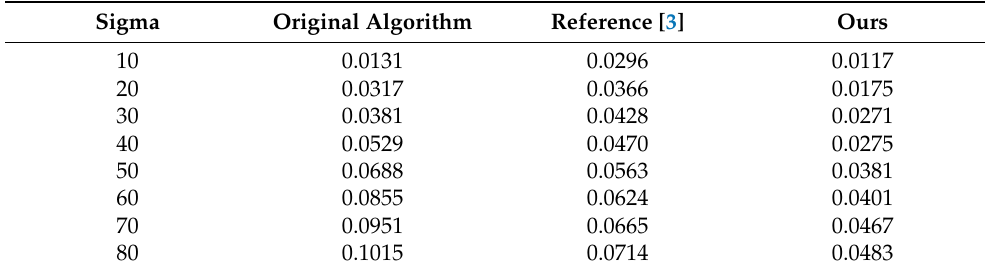
Figure 1. Detection results of the Cameraman image by the tested algorithms at different noise levels. ( a ) Experimental image, and Gaussian noises with standard deviations of 0, 30, 40 and 80 are added, respectively; ( b ) detection result of the traditional Sobel operator; ( c ) detection result of the algorithm proposed in Reference [3]; ( d ) detection result of the algorithm in this paper. Table 1. Mean square error (MSE) of the three algorithms for the Cameraman